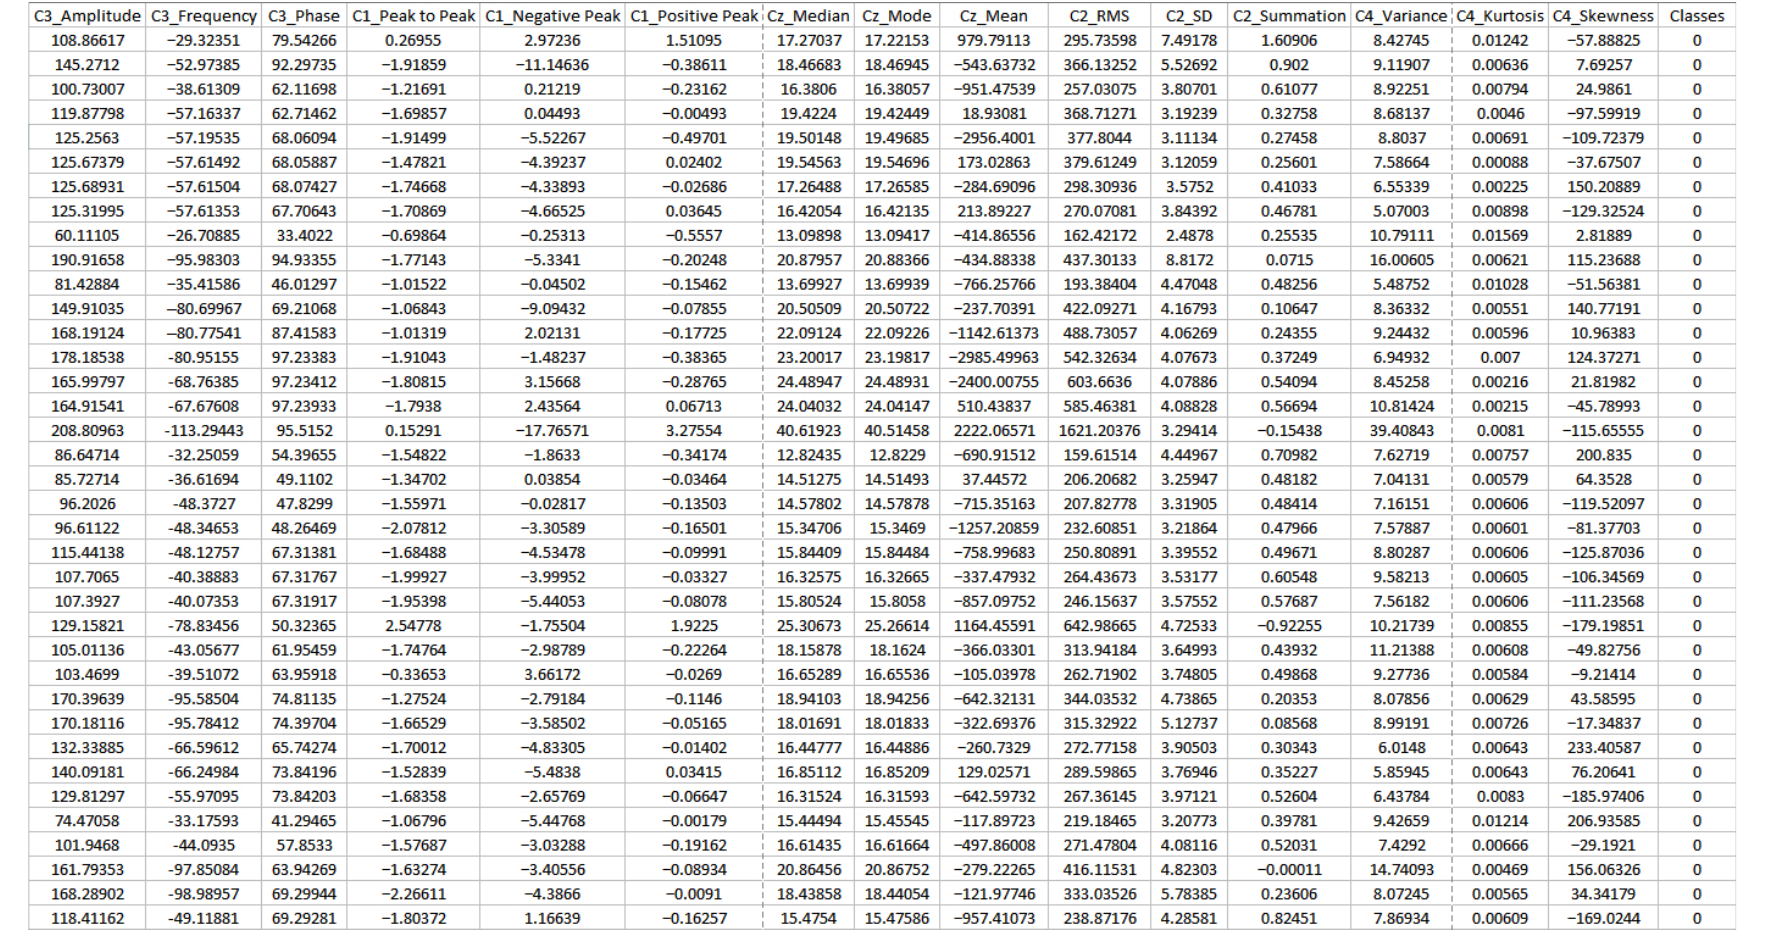
Figure A1. Fragment of the dataset created for this